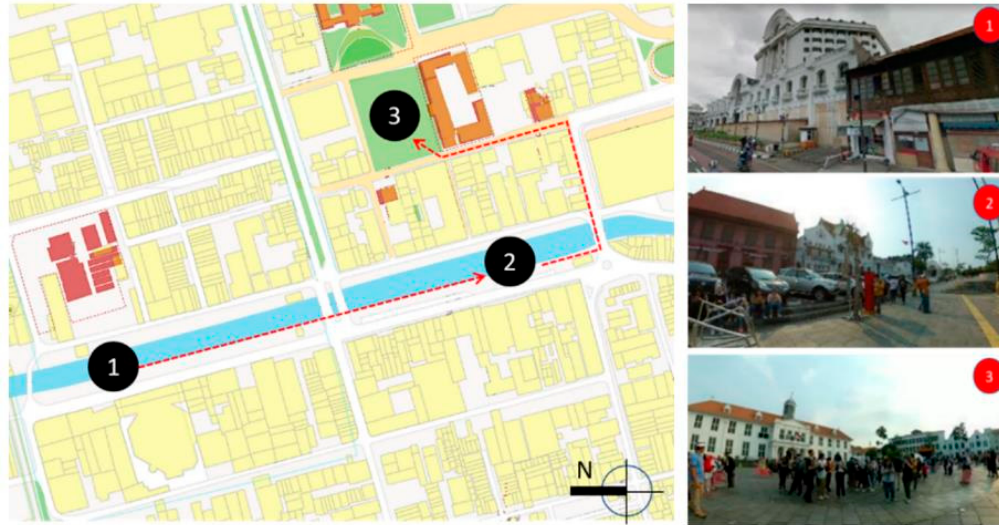
Figure 3. The route of soundwalk in Old Town of Jakarta. The location of Soundwalk assessment: (1) North Kali Besar (2) South Kali Besar (3) Fatahillah Square.